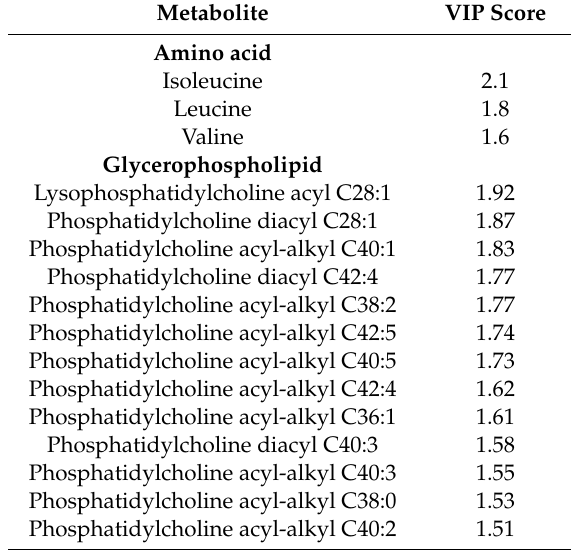
Table 2. Amino acids and phospholipids that had a variable importance in projection (VIP) score > 1.5 at baseline for the prediction of incident diabetes within 5 years.